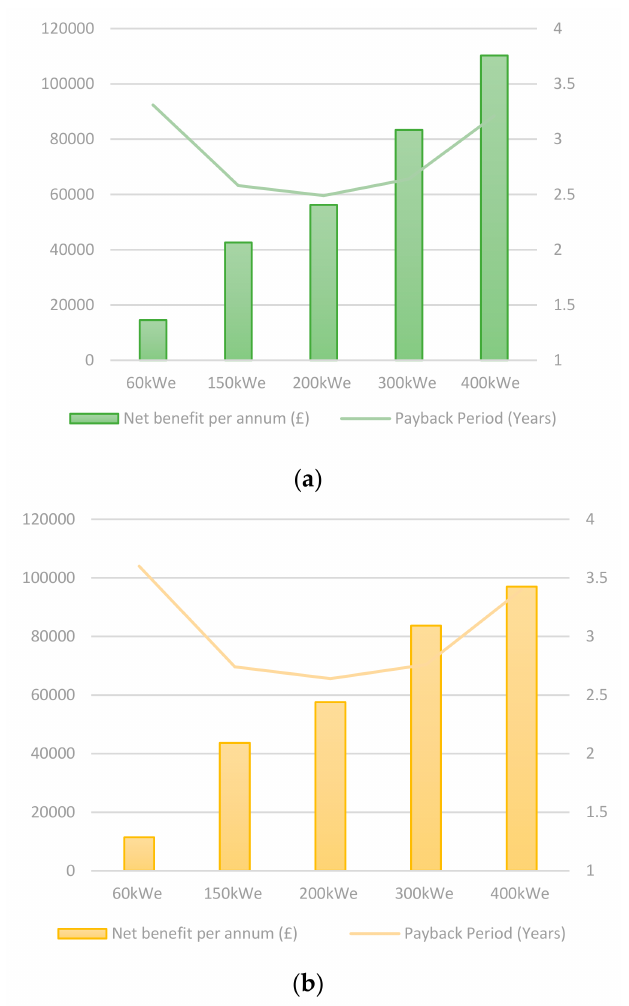
Figure 7. ( a ) Comparison of net benefit per annum and payback calculation for CHP and ( b )